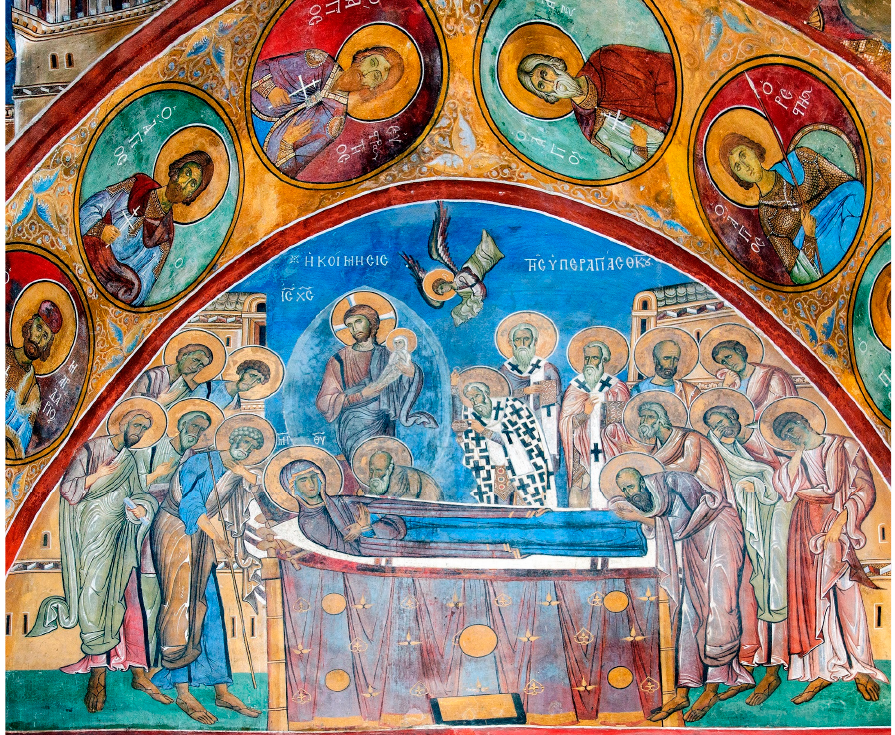
Figure 2. Dormition of the Theotokos , wall painting, 1192, Church of The Panagia tou Araka, Lagoudera, Cyprus. (Photo credit: Angel Yordanov, TerraByzantica ).